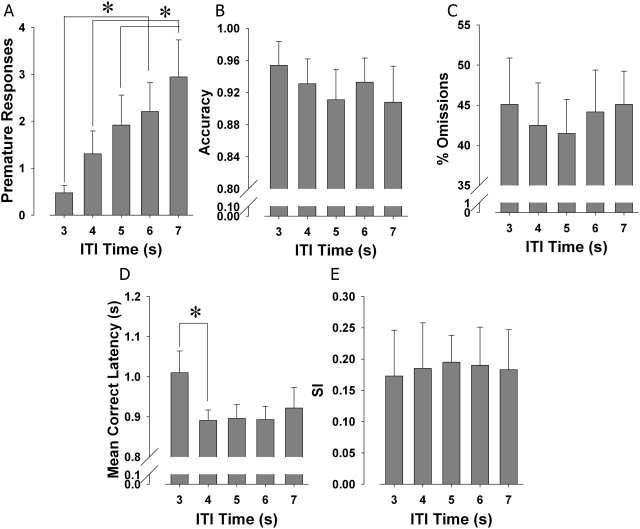
5C-CPT extended session performance of mice binned by ITI time.The 5C-CPT included a variable inter-trial interval (ITI; variable period after which the cue stimulus can appear), ranging from 3–7 s. Performance of the two strains was binned according to ITI time and compared, to assess the effects of ITI bin on performance. No interaction between strain and ITI time was observed for any measure. Increased premature responses were observed with increasing ITI time (A), demonstrating the temporal impulsivity resulting from consistent training in this variable ITI. No significant effects of ITI time on accuracy (B) were observed, nor on %Omissions (C). A significant main effect of ITI time on RT was observed, with performance being fastest at the middle ITI times. No significant main effects of ITI time on SI (F) were observed, although, consistent with %Omissions and RT, the best performance appeared at the center ITI times. Data presented as mean+s.e.m., and * denotes p<0.05 when compared to ITI time indicated.